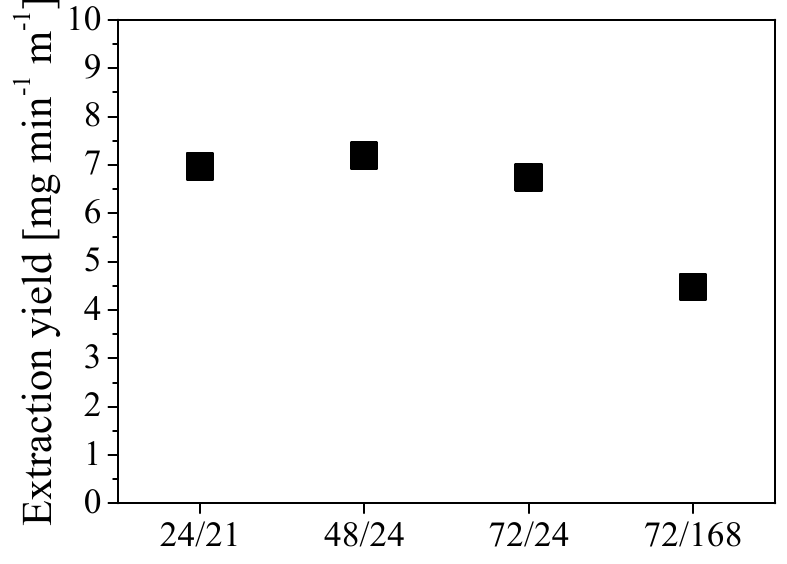
Figure 8. Extraction yield at different combinations t press / t rest , expressed in operating hours.